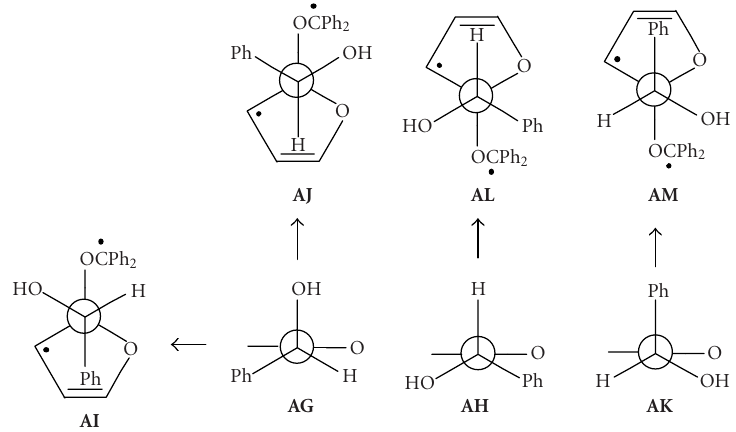
Figure 16: Possible conformations of the biradical intermediate from the reaction of 2-furylphenylmethanol with